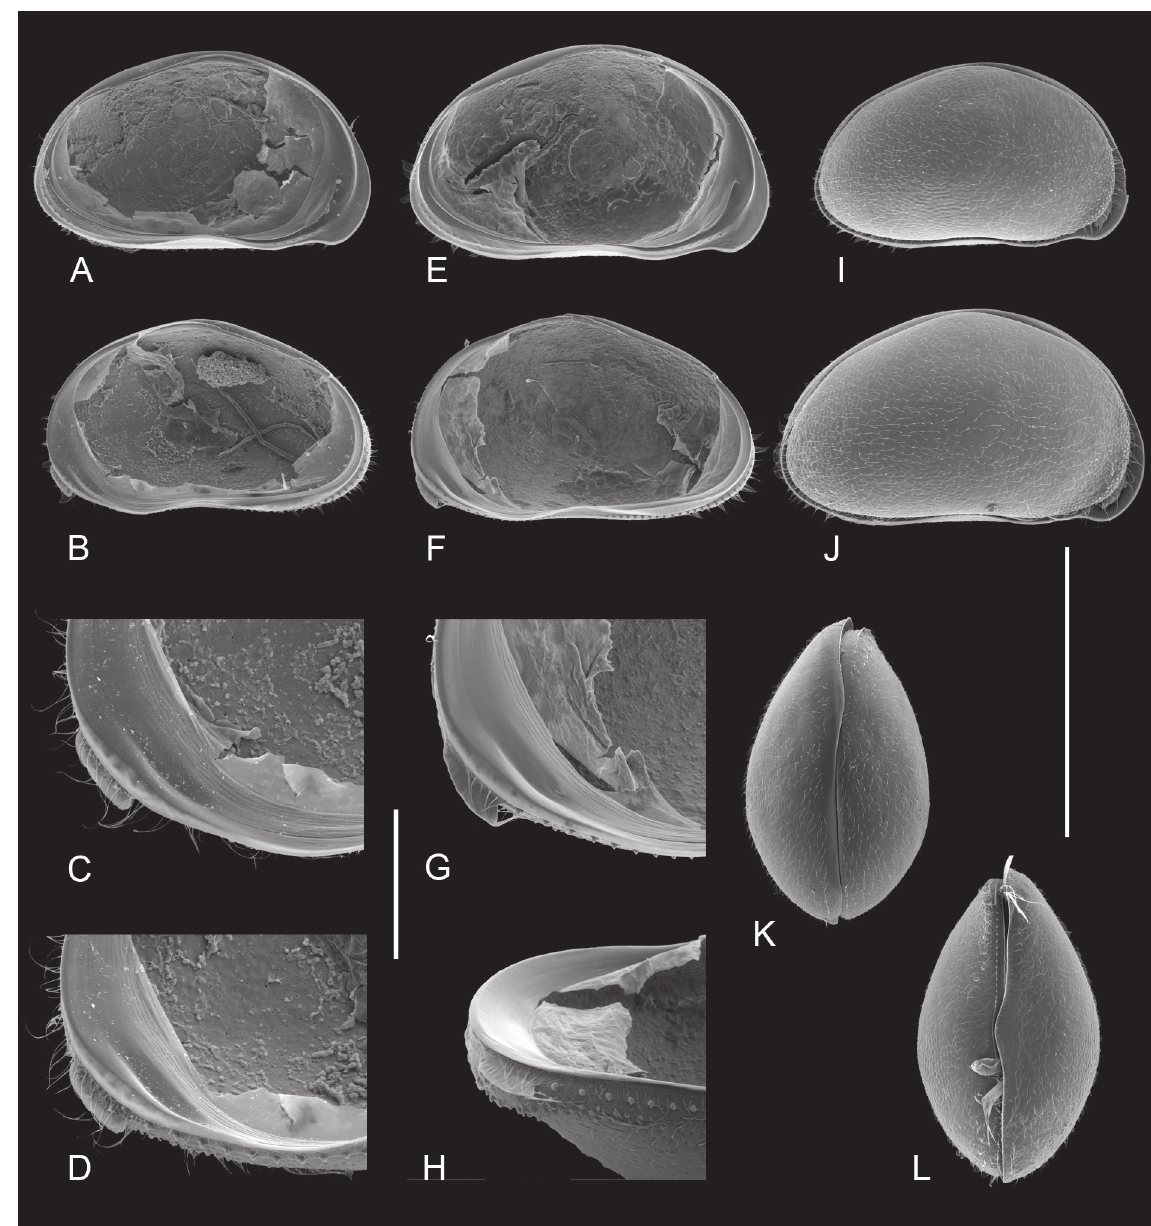
Fig. 23. Bennelongia dedeckkeri , non-type females. — A-D , I , K-L . Dam at Kijlena Well, Pilbara (KIes/10). A . lVi (WaMc52357). B . rVi (idem). C . rVi, detail anterior (idem). D . rVi, detail anterior, slightly tilted (idem). I . cprl (Oc.3350). K . cpD (WaMc52360). L . cpV (WaMc52359). — E-H , J . Mcneil claypan, Murchinson/Gascoyne (sIKe9). E . lVi (Oc.3351). F . rVi (idem). G . rVi, detail anterior (idem). H . rVi, detail anterior, tilted (idem). J . cprl (Oc.3352). scales: a-B, e-F, I-l = 1 mm; c-D, G-H = 200